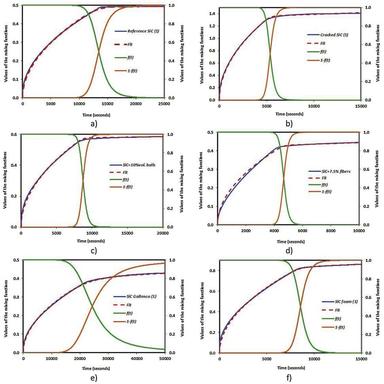
Experimental and fitted time dependence of the weight gain during hexadecane capillary rise and fitted values of f ( )t and 1 − f t( ):a) reference SiC (R1), b) Cracked SiC (C1), c) SiC + balls (B10), d) SiC + fibers (F7.5), e) SiC supplied by Galtenco (G1), and f) SiC foams supplied by SICAT (F1).